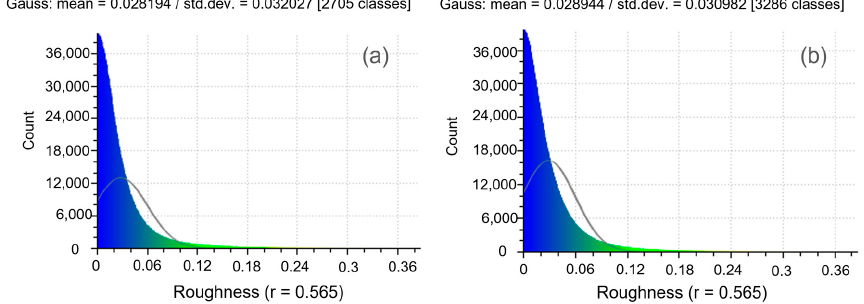
Figure 11. Histogram of roughness (r = 0,565): ( a ) case A and ( b ) case B.